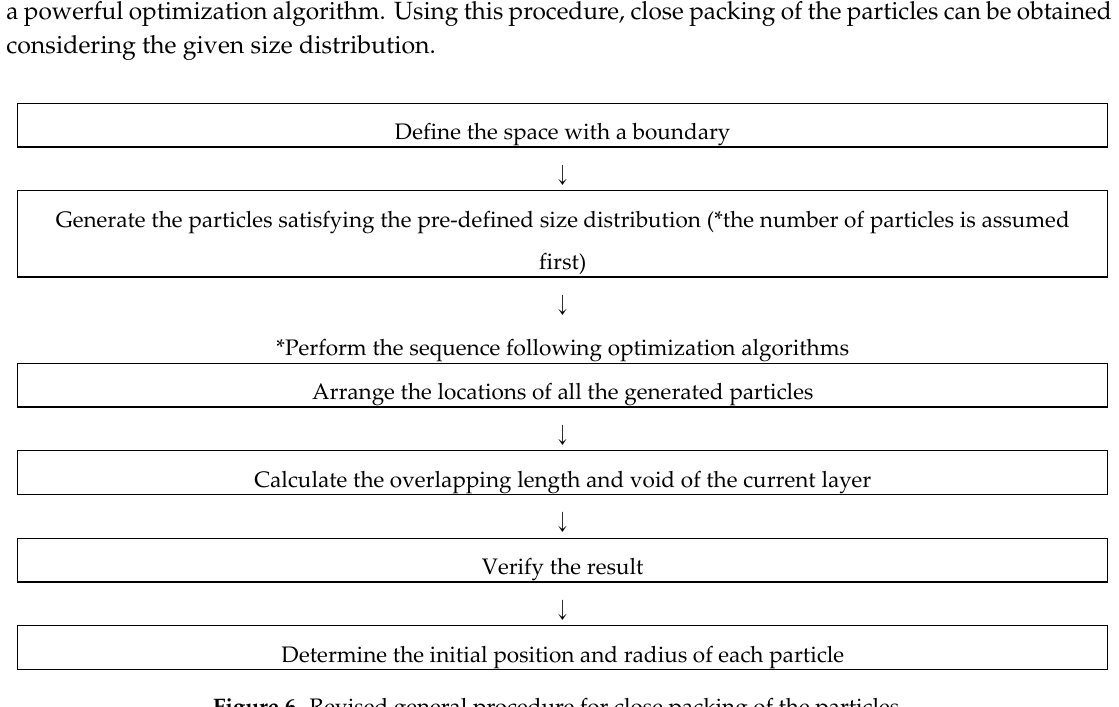
Figure 6. Revised general procedure for close packing of the particles.